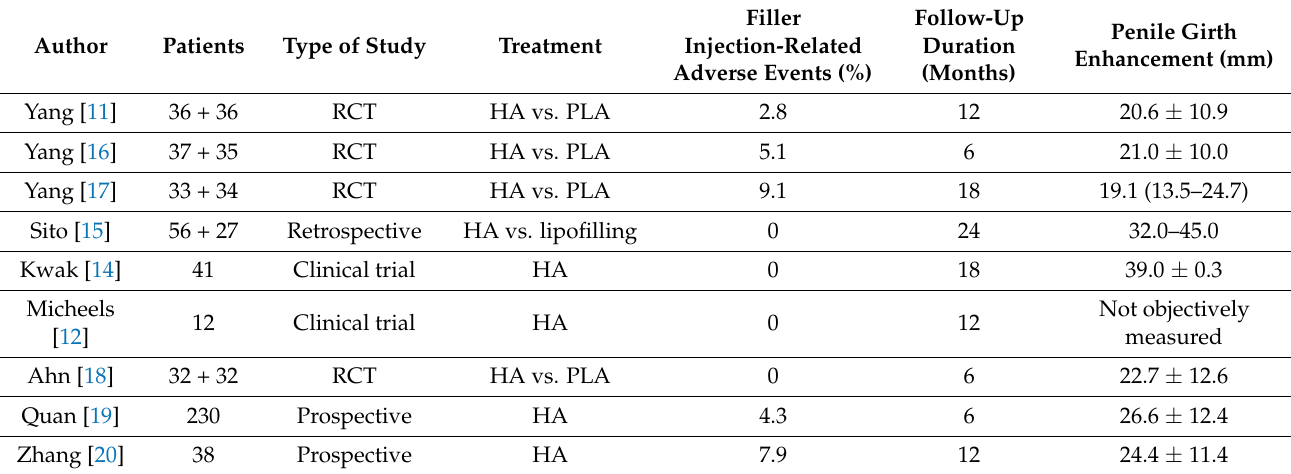
Table 1. Studies dealing with the use of HA for penile enlargement